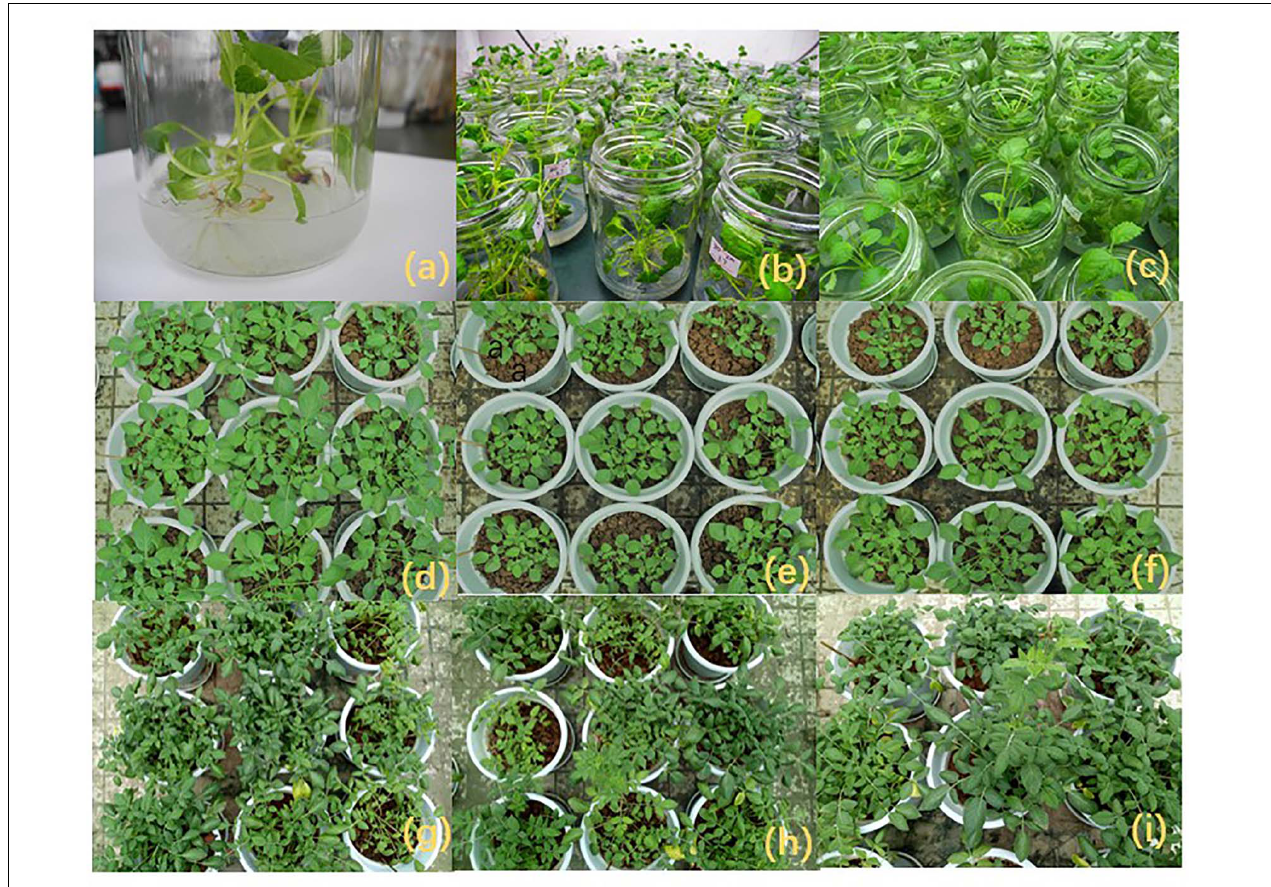
FIGURE 1 | The growth of S. miltiorrhiza was is in good condition during the period of test-tube seedlings and potted. (a–c) The growth of rooted shoots (5 cm in length) which could be transplanted. (d – f) The growth of transplanted S. miltiorrhiza after 70 days. (g–i) The growth of S. miltiorrhiza after 150 days.